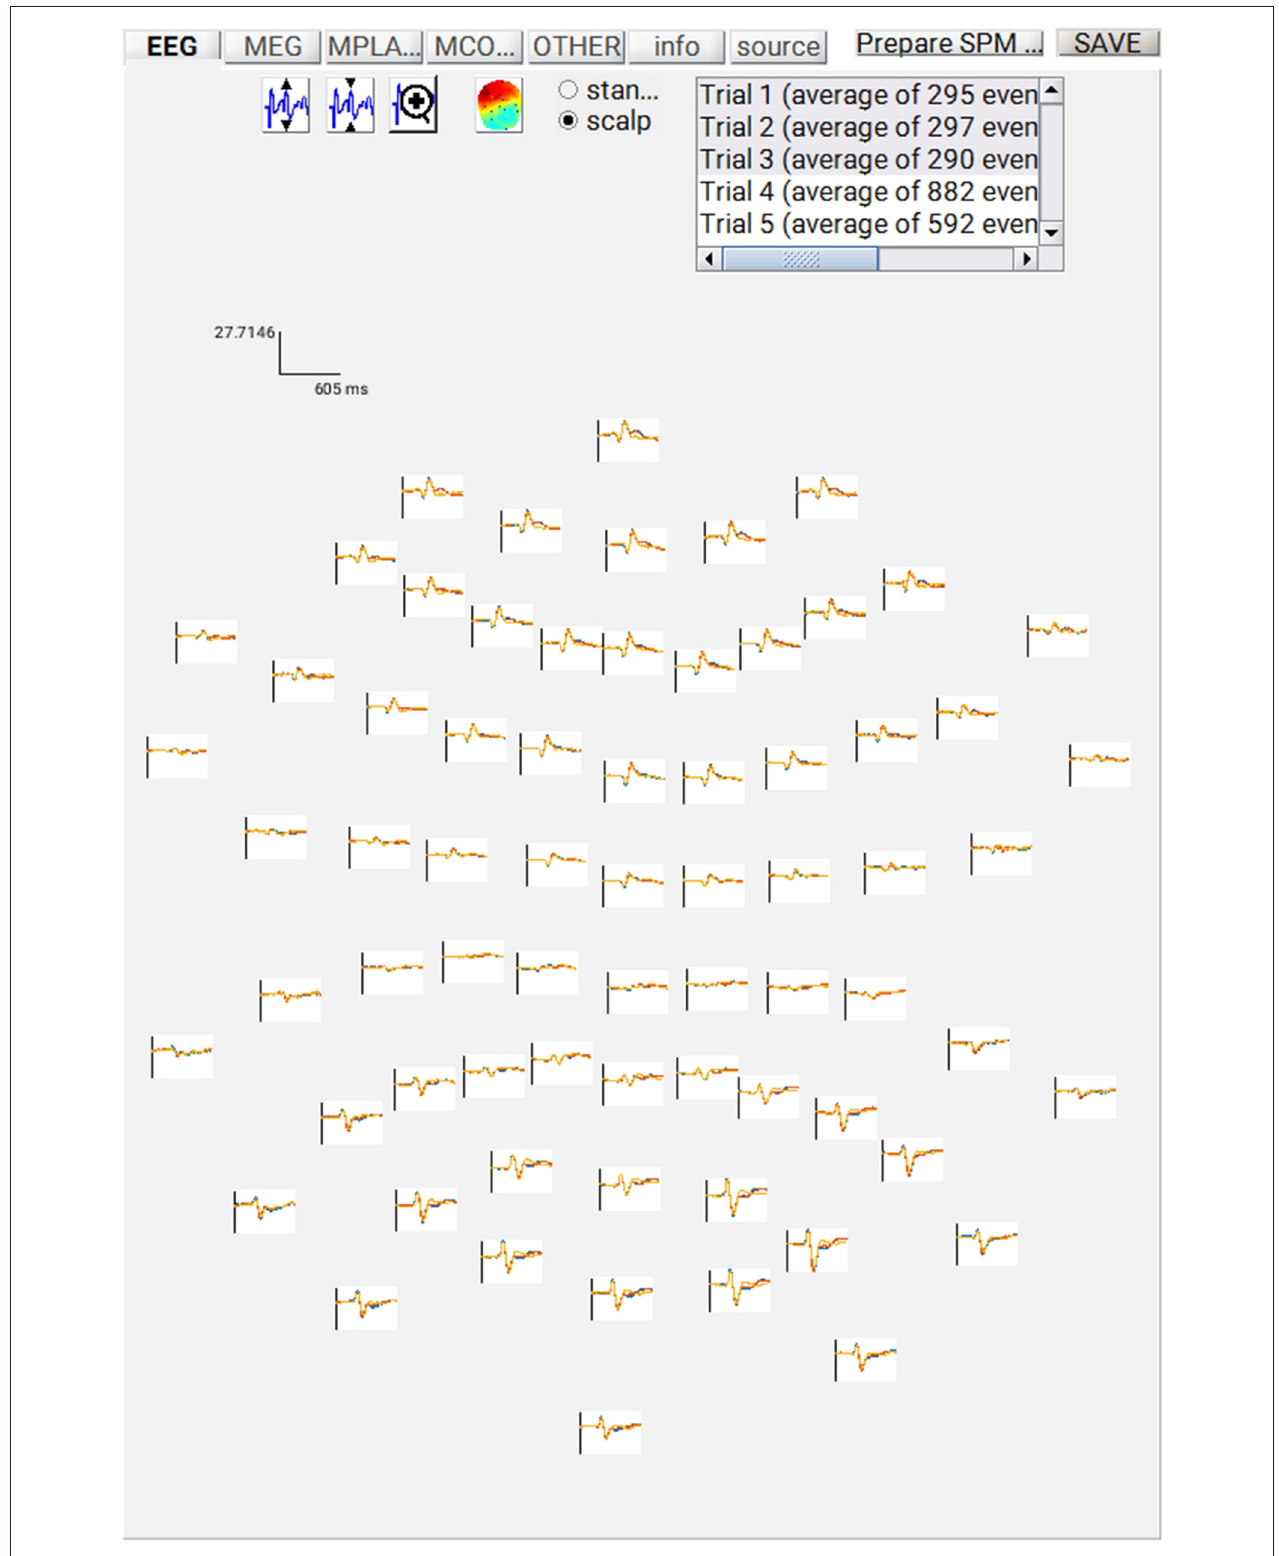
FIGURE 4 | Trial-averaged ERPs for each condition over all EEG channel positions on the scalp.